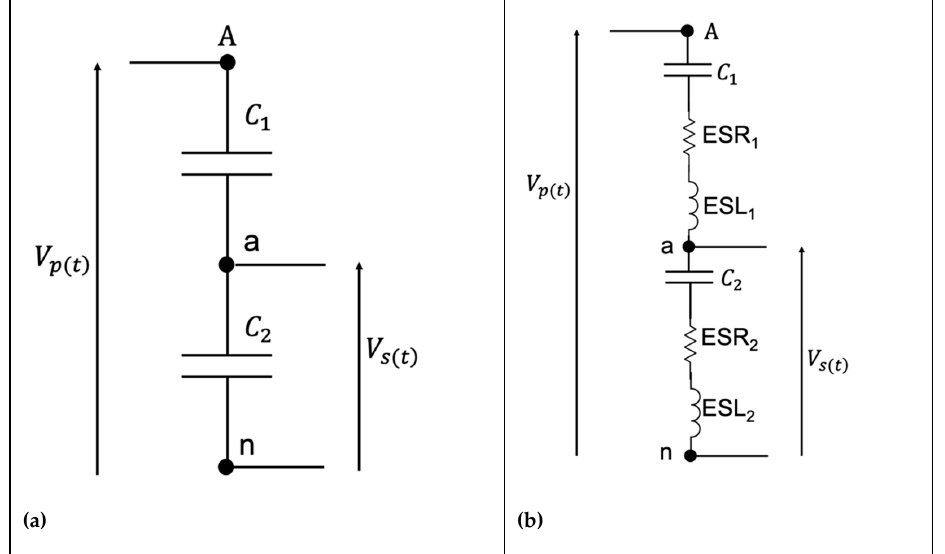
Figure 1. ( a ) The ideal equivalent circuit of a capacitive divider; ( b ) The real equivalent circuit of a capacitive divider.